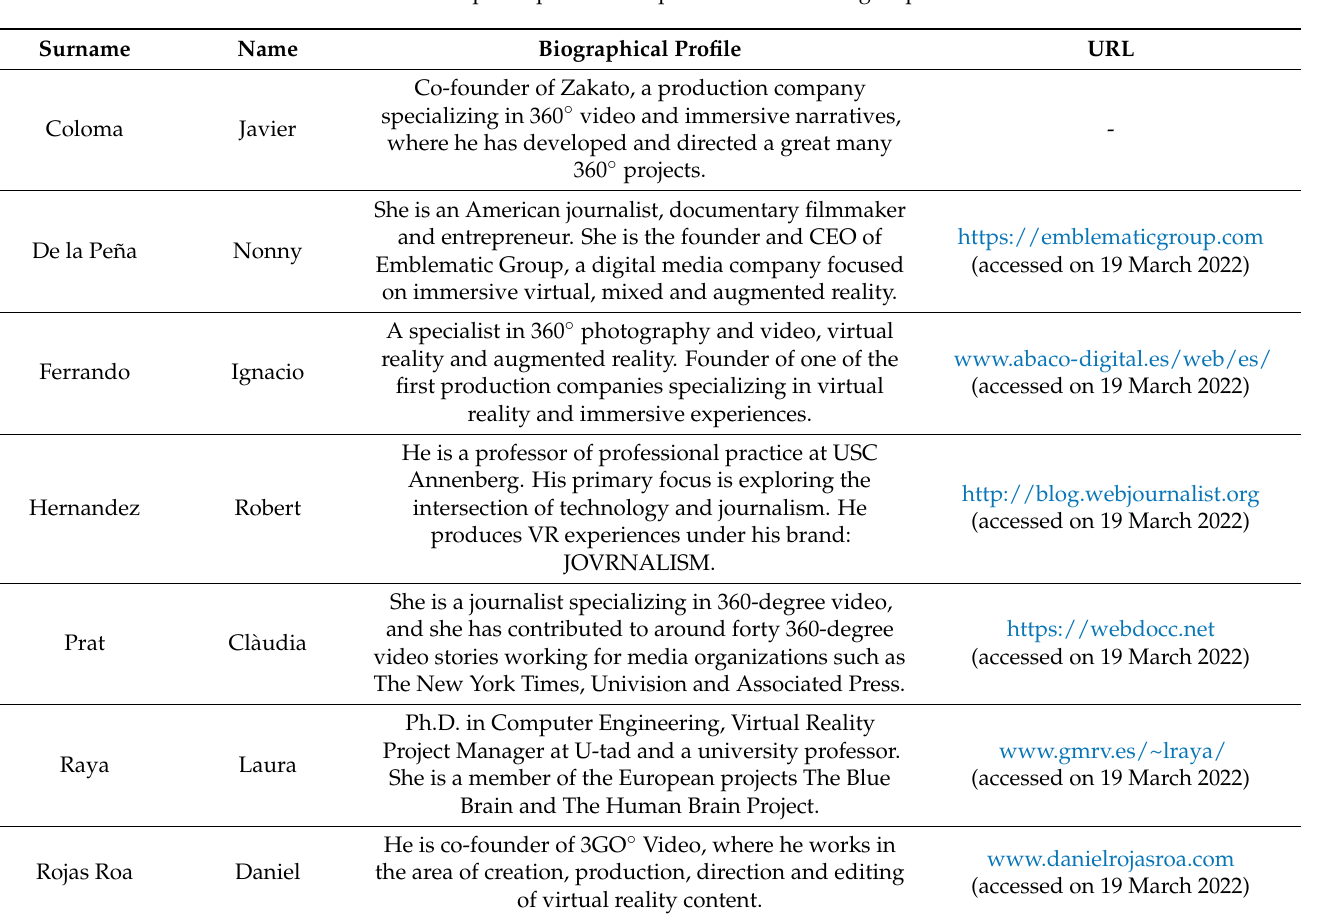
Table 3. List of participants in the professionals’ focus